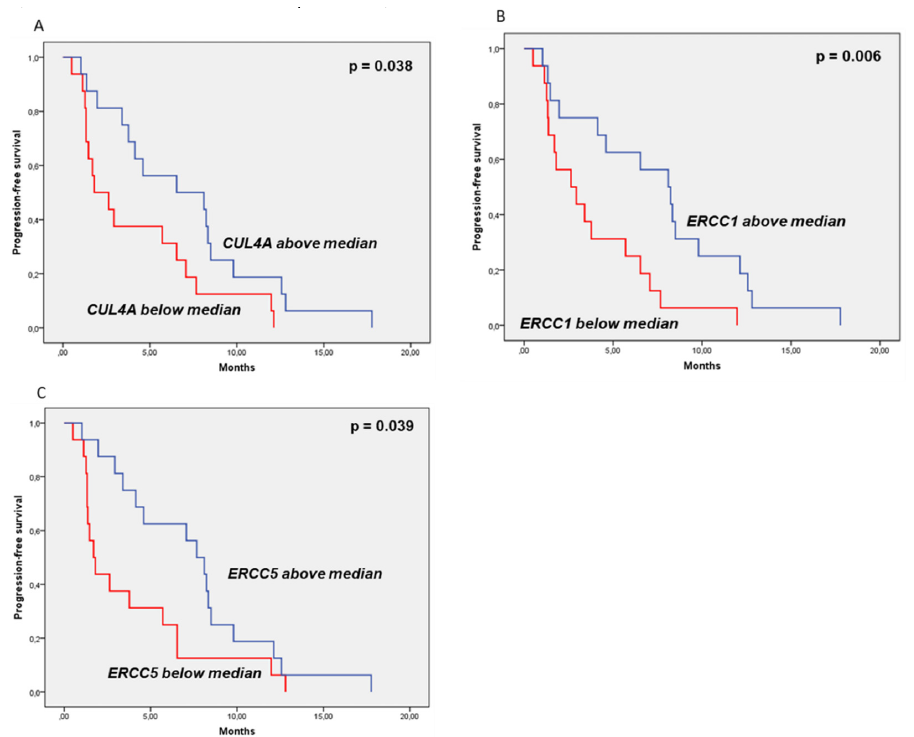
Figure 1. Prognostic and predictive value of DNA-damage repair genes. Samples were grouped taking into account the median of gene expression. ( A ) high expression of CUL4A significantly correlated with better progression-free survival (PFS) on trabectedin plus doxorubicin arm (6.53 months (95% CI: 0.00–13.39) vs 1.80 months (95% CI: 0.00–3.63); p = 0.038); ( B ) high expression of ERCC1 significantly correlated with better (PFS) on trabectedin plus doxorubicin arm (8.10 months (95% CI: 4.77–11.43) vs 2.63 months (95% CI: 0.41–4.86) p = 0.006) and ( C ) high expression of ERCC5 significantly correlated with better PFS on trabectedin plus doxorubicin arm (7.67 months (95% CI: 5.64–9.69) vs 1.70 months (95% CI: 1.05–2.35); p =